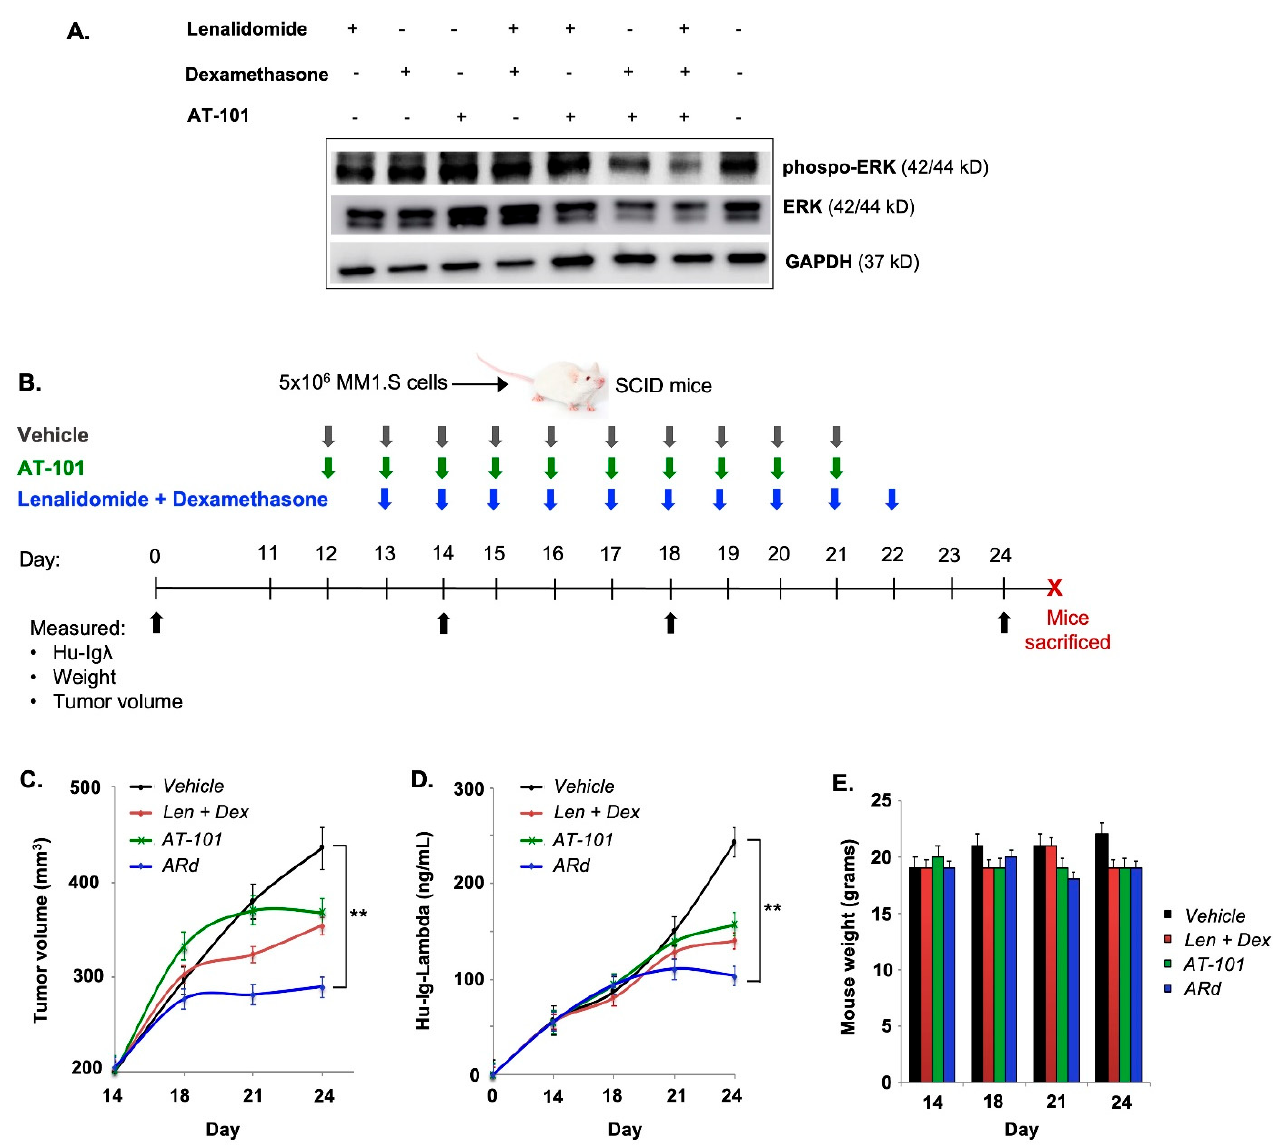
Figure 2. AT-101 enhances the in vivo anti-tumor effects of lenalidomide and dexamethasone in a xenograft model of human myeloma. ( A ) Western blot analysis for ERK and phospho-ERK (pERK) in KMS-11 cells treated with lenalidomide (1 uM), dexamethasone (1 uM), AT-101 (1 uM) or the combination (ARd) for 24 h relative to untreated cells. ( B ) In vivo activity of AT-101 in combination with lenalidomide and dexamethasone Female SCID mice were xenografted with human lambda light chain (Hu-Ig λ ) secreting MM1.S myeloma cells. Once tumors reached a median volume of ~200 mm 3 (Day 14), mice were randomized to 4 groups ( n = 10/group) receiving either DMSO (vehicle), AT-101 (35 mg/kg per oral gavage), lenalidomide (10 mg/kg, intraperitoneal injection) and dexame- thasone (0.5 mg/kg, intraperitoneal injection) or the combination of the 3 drugs (ARd), for 10 con- secutive days. ( C ) Tumor volume was estimated every 4 days post-randomization and reached an average of ~410 mm 3 in the control group by Day 24. This contrasted with the mice that received treatment with Ld or AT-101, whose tumors grew to an average of ~330 mm 3 . A significant reduction in tumor volume was observed in mice treated with the ARd combination, with most mice showing little to no increase in tumor size beyond 254 mm 3 . ( D ) Next, we examined Hu-Ig λ secretion in mice sera by ELISA and consistent with tumor growth pattern, we observed significantly lower Hu-Ig λ levels in mice treated with LDA. ( E ) Notably, treatment with either AT-101, lenalidomide and dex- amethasone or ARd did not result in significant weight loss or other toxicities. Data shown are mean ± SD (** p < 0.01). Uncropped WB images were shown in Figure S7.